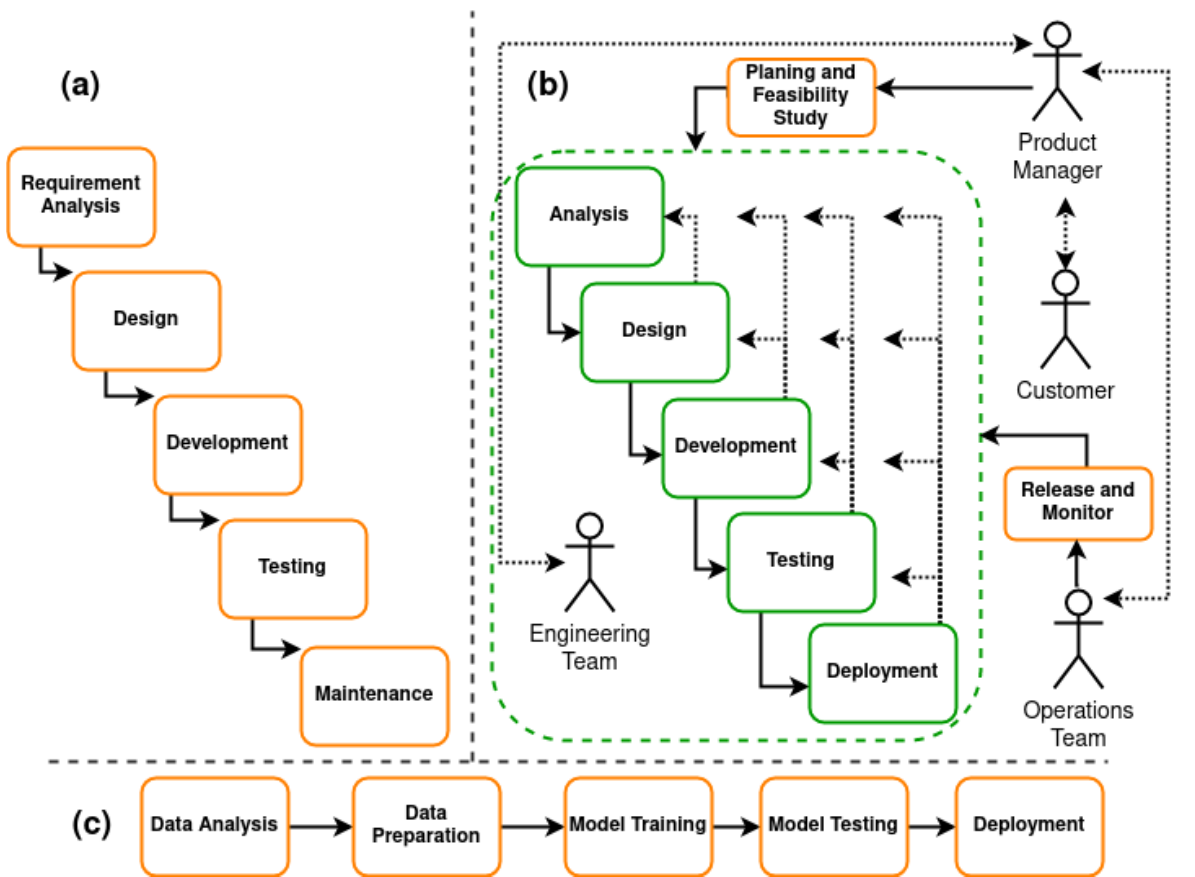
Figure 1. ( a , b ) Difference between Waterfall and DevOps software development life cycle. ( c ) A manual ML